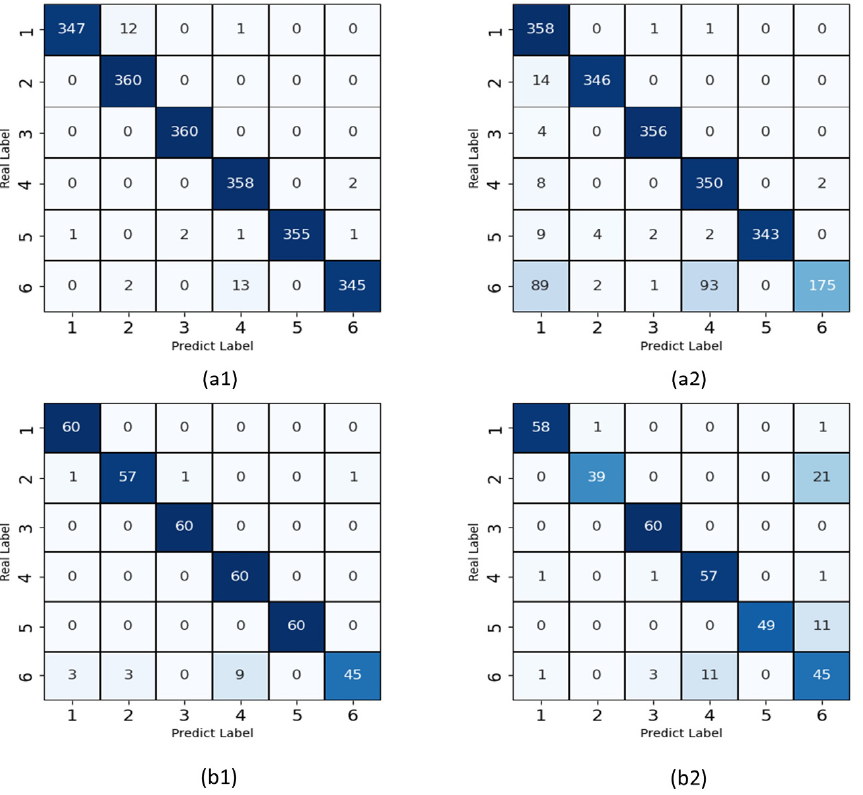
maximum and minimum accuracies on Kinect25, respectively, ( b1 ) and ( b2 ) are the training models with